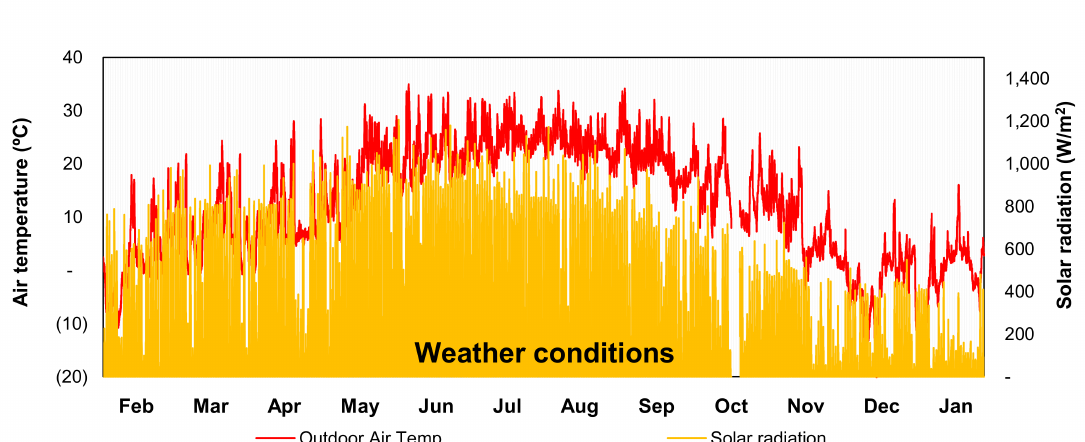
Figure A2. Experimental data for balcony pair